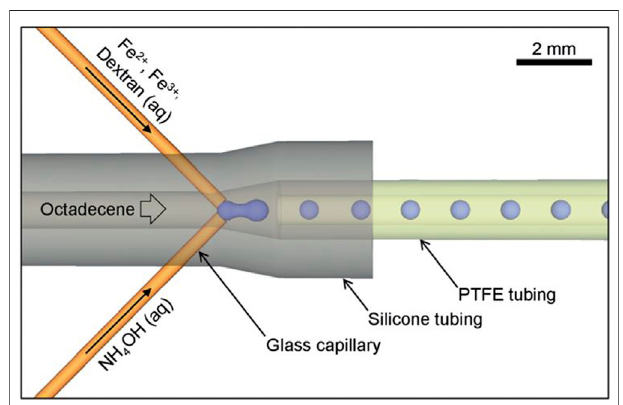
FIGURE 3 | Schematic of the capillary-based droplet reactor showing the injection of separate precursor streams of Fe 2+ /Fe 3+ /dextran and NH 4 OH into a continuous stream of octadecene carrier fl uid; iron oxide nanoparticles are formed inside the droplets. Reprinted with permission from (Kumar et al., 2012). Copyright (2021) Royal Society of